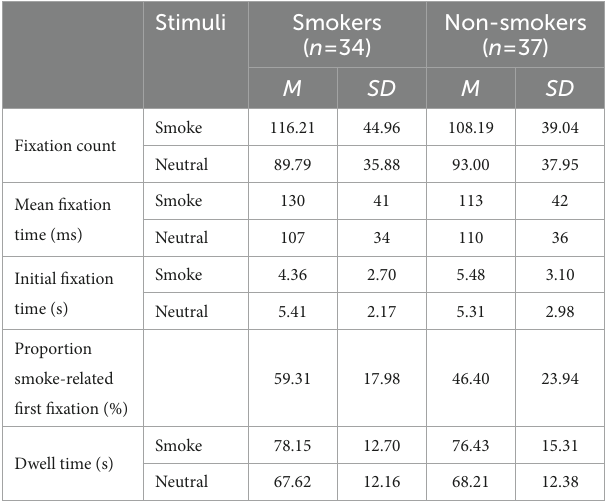
TABLE 2 Descriptive results of eye tracking during the free-viewing task.